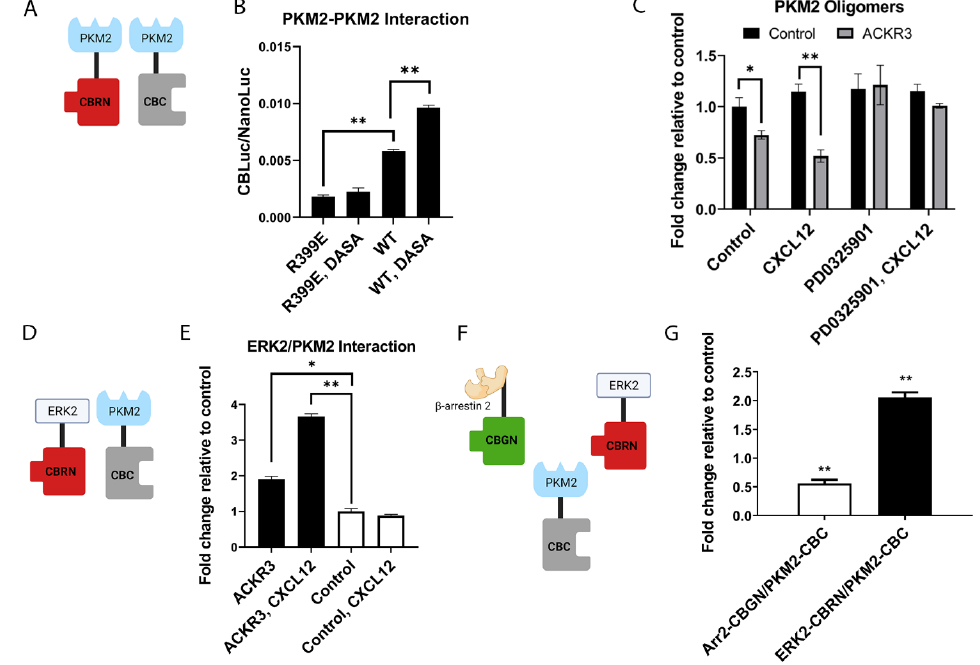
Figure 5. CXCL12-ACKR3 signaling reduces oligomerization of PKM2. ( A ) Illustration of click beetle complementation system for PKM2 dimers based on interaction between PKM2-CBRN and PKM2-CBC. ( B ) Graphs show mean values + SEM for bioluminescence produced by 293T cells transiently transfected with WT or R399E PKM2-CBRN and PKM2-CBC complementation pairs. We treated cells with 30 µ M DASA-58, a compound that promotes tetramerization of WT PKM2, for 3 h before measuring bioluminescence. WT control cells and cells with R399E PKM2 received vehicle only. ( C ) We transiently transfected 293T cells with WT PKM2 oligomerization reporters and ACKR3-GFP or GFP control. We treated cells with 100 nM of the MEK inhibitor PD0325901 or vehicle for one hour before adding 100 ng/mL CXCL12- α . Graphs show mean values + SEM for bioluminescence measured 20 min after adding CXCL12 and normalized to control cells. ( D ) Complementation scheme for association between ERK2-CBRN and PKM2-CBC. ( E ) We transiently transfected 293T cells with WT PKM2 oligomerization reporters and ACKR3-GFP or GFP control. We treated cells with 100 nM of the MEK inhibitor PD0325901 or vehicle for one hour before adding 100 ng/mL CXCL12- α . Graphs show mean values + SEM for bioluminescence measured 20 min after adding CXCL12 and normalized to control cells. ( F ) Dual-color complementation assay for interactions of β -arrestin 2- CBGN or ERK2-CBRN with PKM2-CBC. ( G ) We co-transfected 293T cells with the complementation pair of ERK2-CBRN and PKM2-CBC and ACKR3-GFP or GFP control. Graphs depict mean values + SEM normalized to control cells for bioluminescence measured 20 min after adding 100 ng/mL CXCL12- α . ( D ) Graphs show mean values + SEM for bioluminescence in green and red channels from cells expressing β -arrestin 2-CGBN (Arr2-CBGN), ERK2-CBRN, and PKM2-CBC. We measured bioluminescence 20 min after adding 100 ng/mL CXCL12- α and normalized data to control cells not treated with CXCL12- α . * p < 0.05; ** p < 0.01. Illustrations created with BioRender.com (accessed on 28 April